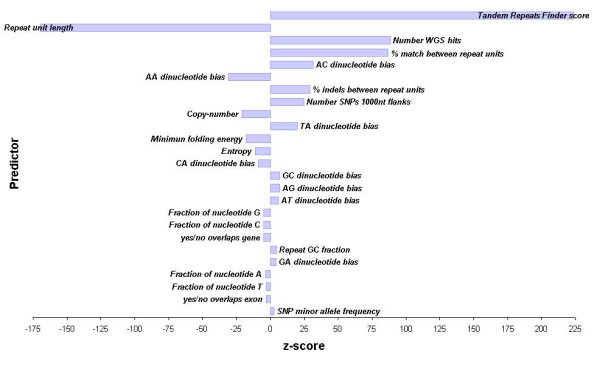
Significant predictors of repeat variability from the generic logistical model, sorted by absolute value of the z-score.